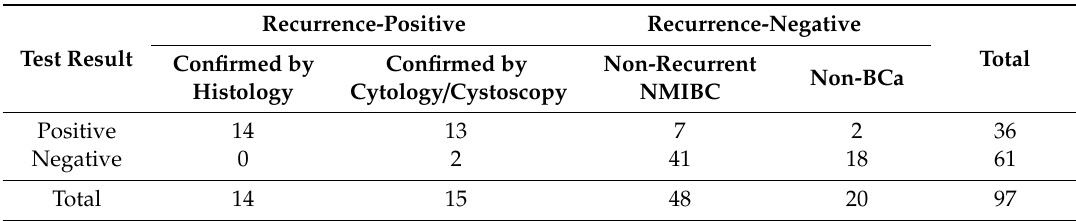
Table 2. Test performances in enrolled patients ( n = 97), per subgroup.